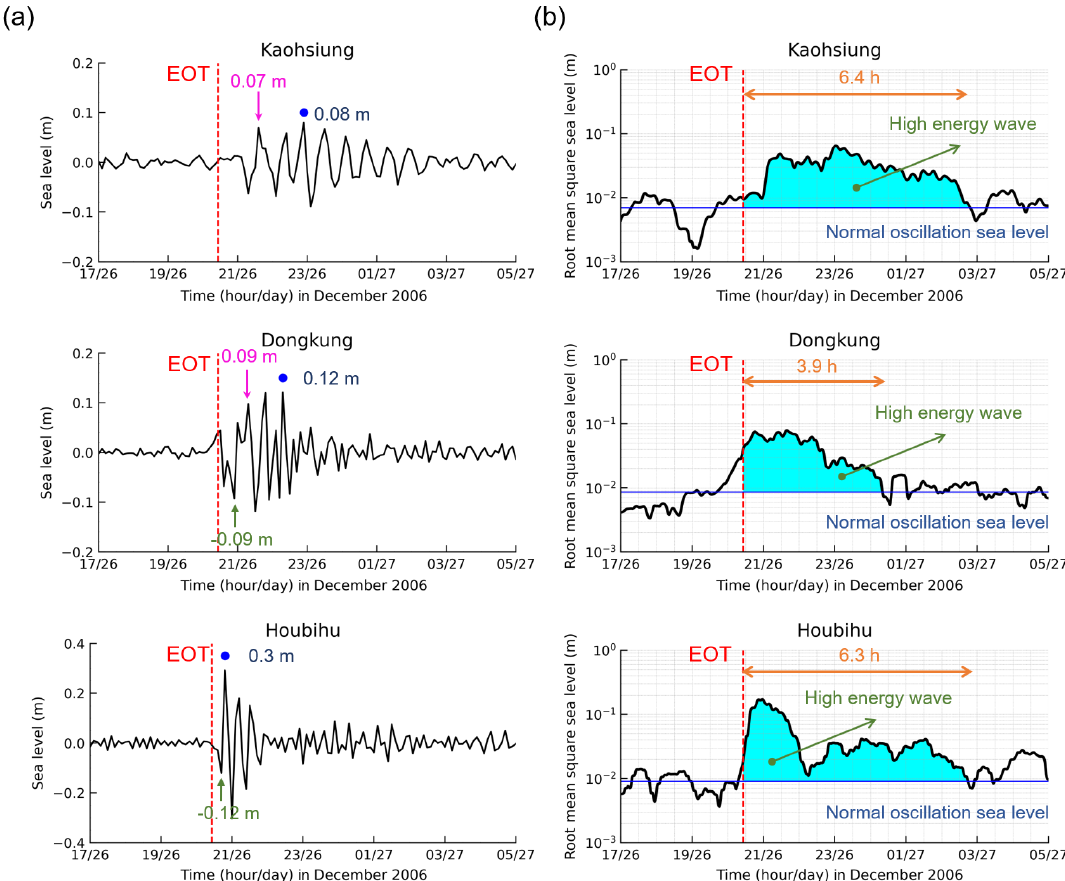
Figure 9. (a) The observed tsunami waveforms and (b) diagrams of root mean square (RMS) sea levels of the 2006 tsunami at the Kaohsiung, Dongkung, and Houbihu tide gauge stations. The vertical, dashed red lines indicate the earthquake occurrence time (EOT). The blue circles denote the arrival of the maximum crest wave that was recorded at all sites. The pink arrows mark the first wave crest. The green arrows represent the trough sign of the first wave arrival. The solid blue lines represent the normal sea level oscillation before the tsunami arrived (i.e., the mean value of sea level before the earthquake occurrence). The high-energy wave is illustrated in cyan-blue shaded areas. The orange arrows show the elapsed time of tsunami